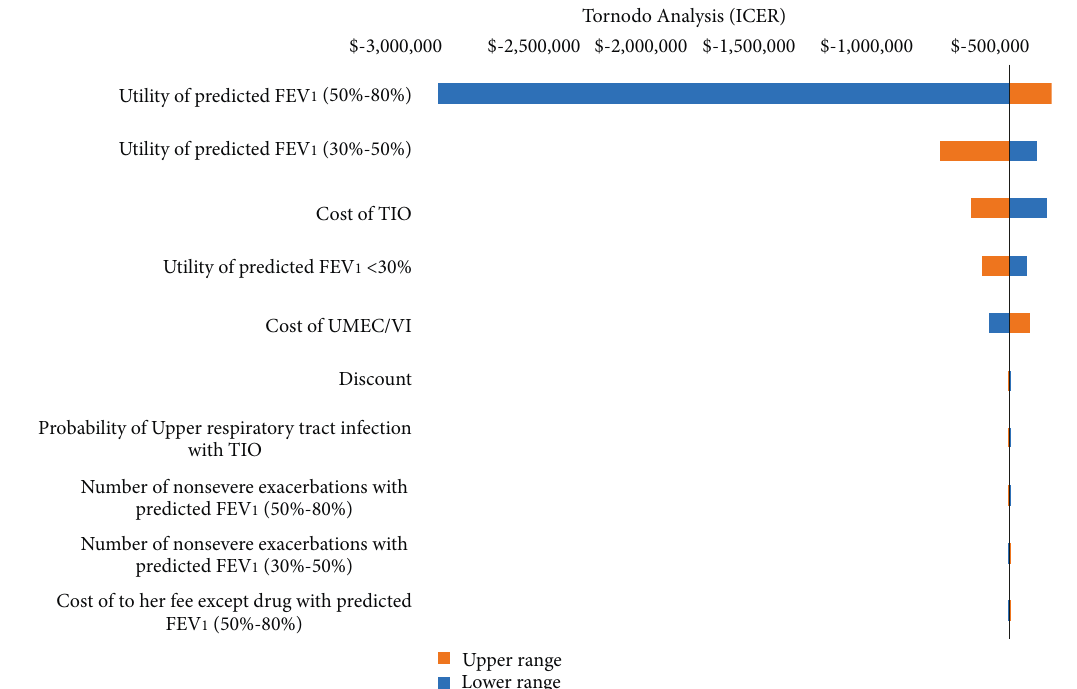
Figure 6: One-way sensitivity analysis. The vertical line in the chart area represents the base ICER value. The width of each bar represents the range of uncertainty associated with each parameter (left of the line: decreased ICER; right of the line: increased ICER).